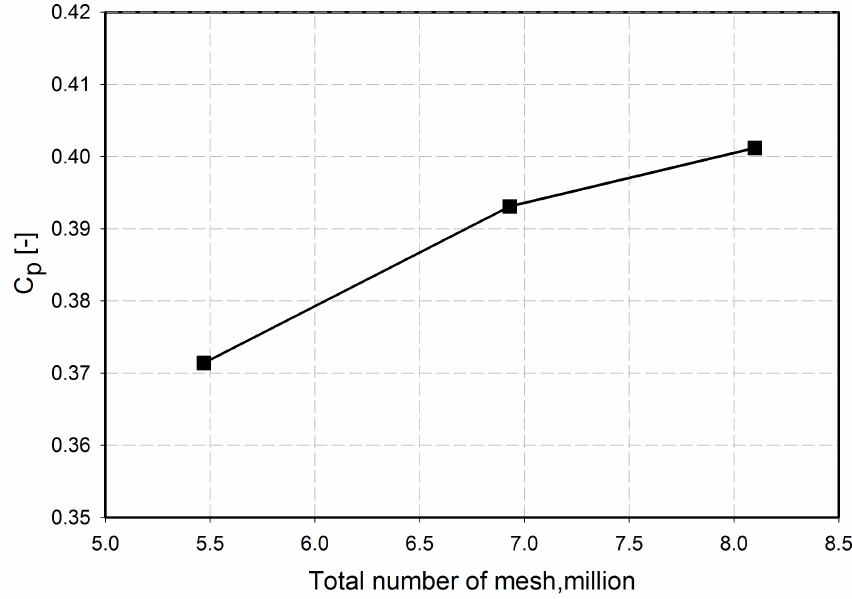
Figure 7. Effect of grid resolution on the calculated C P for the balanced